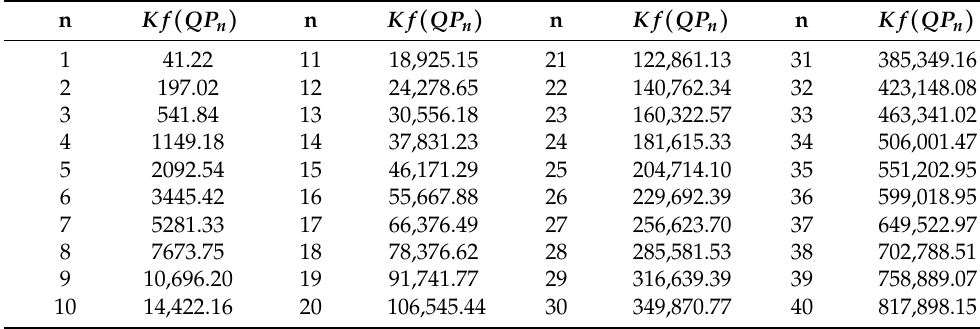
Table 1. The Kirchhoff indices of linear pentagonal derivation chains from QP 1 to QP 40 .